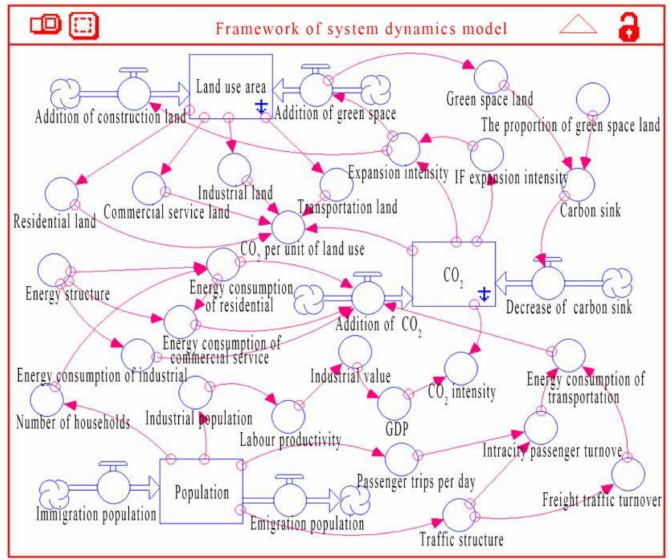
Figure 2. A causal feedback loop diagram for the urban CO 2 emissions